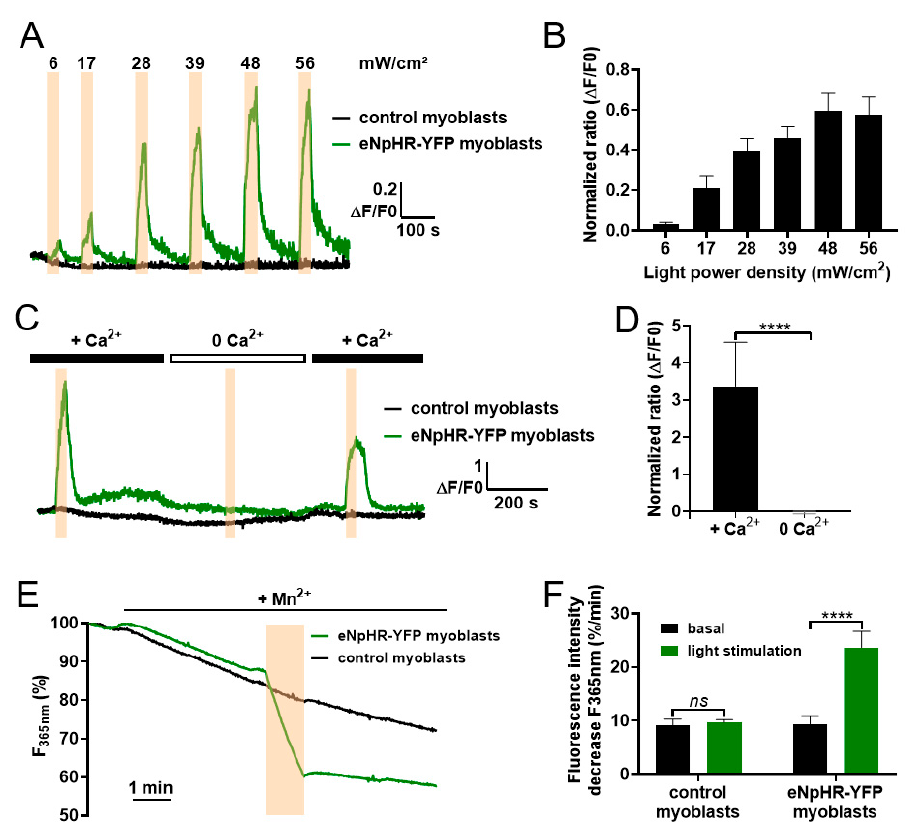
Figure 2. Constitutive calcium entry controlled by light stimulation of eNpHR-expressing C2C12 myoblasts. ( A ) Representative raw data traces of normalized Fura-2 fluorescence ratio at several light intensities (6, 17, 28, 39, 48, 56 mW / cm 2 , duration: 30 s, represented by orange bars) in control C2C12 myoblasts (black) and eNpHR-expressing C2C12 myoblasts (green). ( B ) Maximum amplitude ( ∆ F / F0) of the normalized Fura-2 fluorescence response during light stimulations of variable intensity in eNpHR-expressing C2C12 myoblasts (mean ± SEM, n = 31, p < 0.0001, Kruskal-Wallis test). ( C ) Representative traces of normalized Fura-2 fluorescence ratio during light stimulations (duration: 30 s, 48 mW / cm 2 , orange bars) in control C2C12 myoblasts (black) and eNpHR-expressing C2C12 myoblasts (green) perfused with Tyrode’s solution containing 1.8 mM Ca 2 + or 0 mM Ca 2 + . ( D ) Amplitude ( ∆ F / F0) of the normalized Fura-2 fluorescence response to light stimulation of eNpHR-expressing myoblasts perfused with Tyrode’s solution containing 1.8 mM Ca 2 + or 0 mM Ca 2 + (mean ± SEM, n = 10, p < 0.0001, Mann–Whitney test). ( E ) Representative traces showing Mn 2 + quenching (100 µ M) of Fura-2 fluorescence recorded in control C2C12 myoblasts (gray) and eNpHR-expressing C2C12 myoblasts (green). Cells were stimulated with light (orange bar) for 1 minute at 48 mW / cm 2 . ( F ) Quantitative analysis of the maximum rate of Mn 2 + quenching (% / min) before light stimulation (dark histograms) and during light stimulation at 48 mW / cm 2 (green histograms) in control C2C12 myoblasts and eNpHR-expressing C2C12 myoblasts (mean ± SEM, control myoblasts n = 27; eNpHR myoblasts n = 26, p < 0.0001, Mann–Whitney